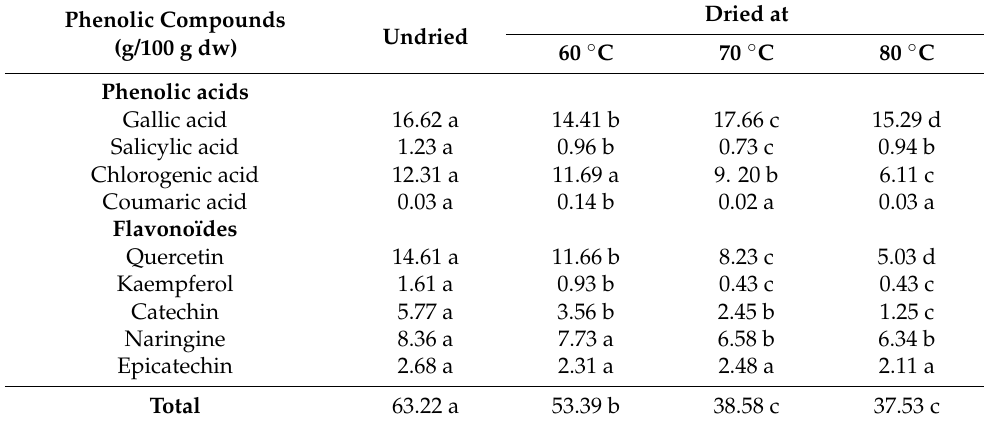
Table 5. Phenolic compounds contents of undried and dried Arbutus unedo L. fruits (Results are expressed as mean values of three determinations; Significant differences at p < 0.05 (Tukey’s test) are indicated with different